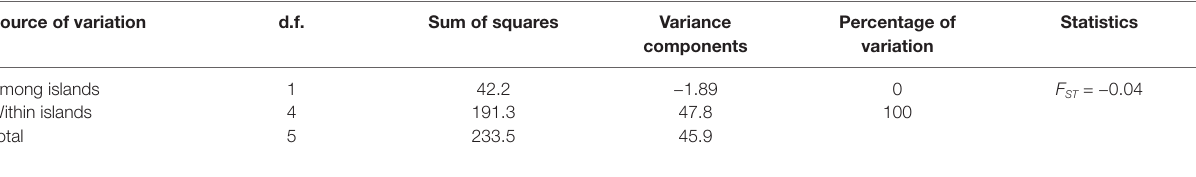
TaBle 4 | AMOVA testing genetic subdivision between islands. Source of